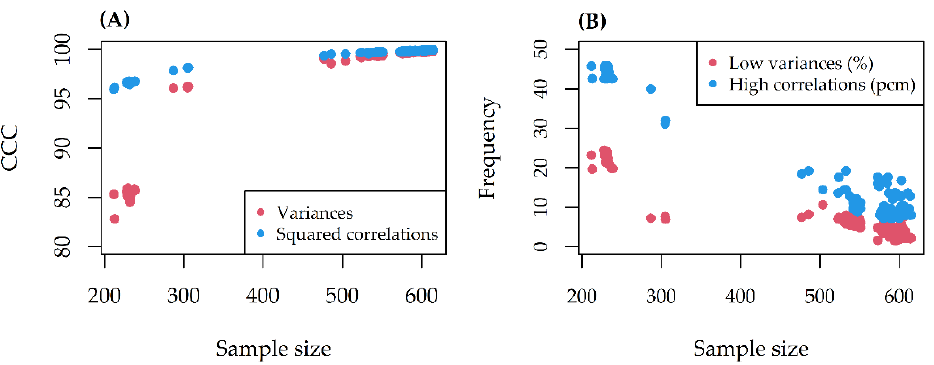
Figure 2. ( A ) Concordance correlation coefficient (CCC) between alteration variances/squared correlations before and after missing data removal, as a function of sample size; ( B ) Frequency of variances/correlations violating the thresholds set, as a function of sample